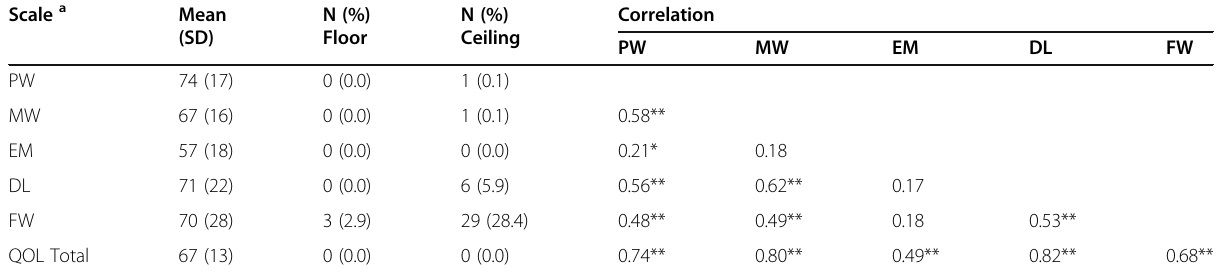
Table 3 Descriptive summary and correlation matrix of quality of life scores Scale a